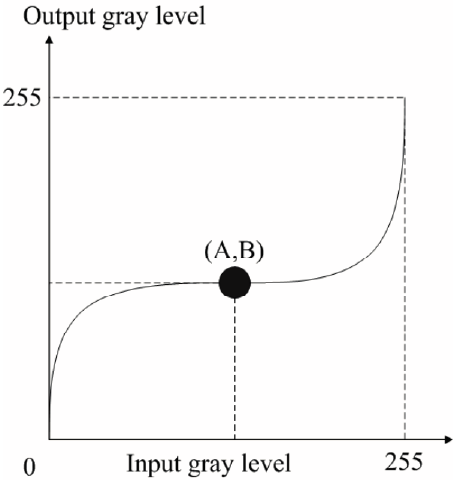
Figure 4. The different compensation curves based on different turning